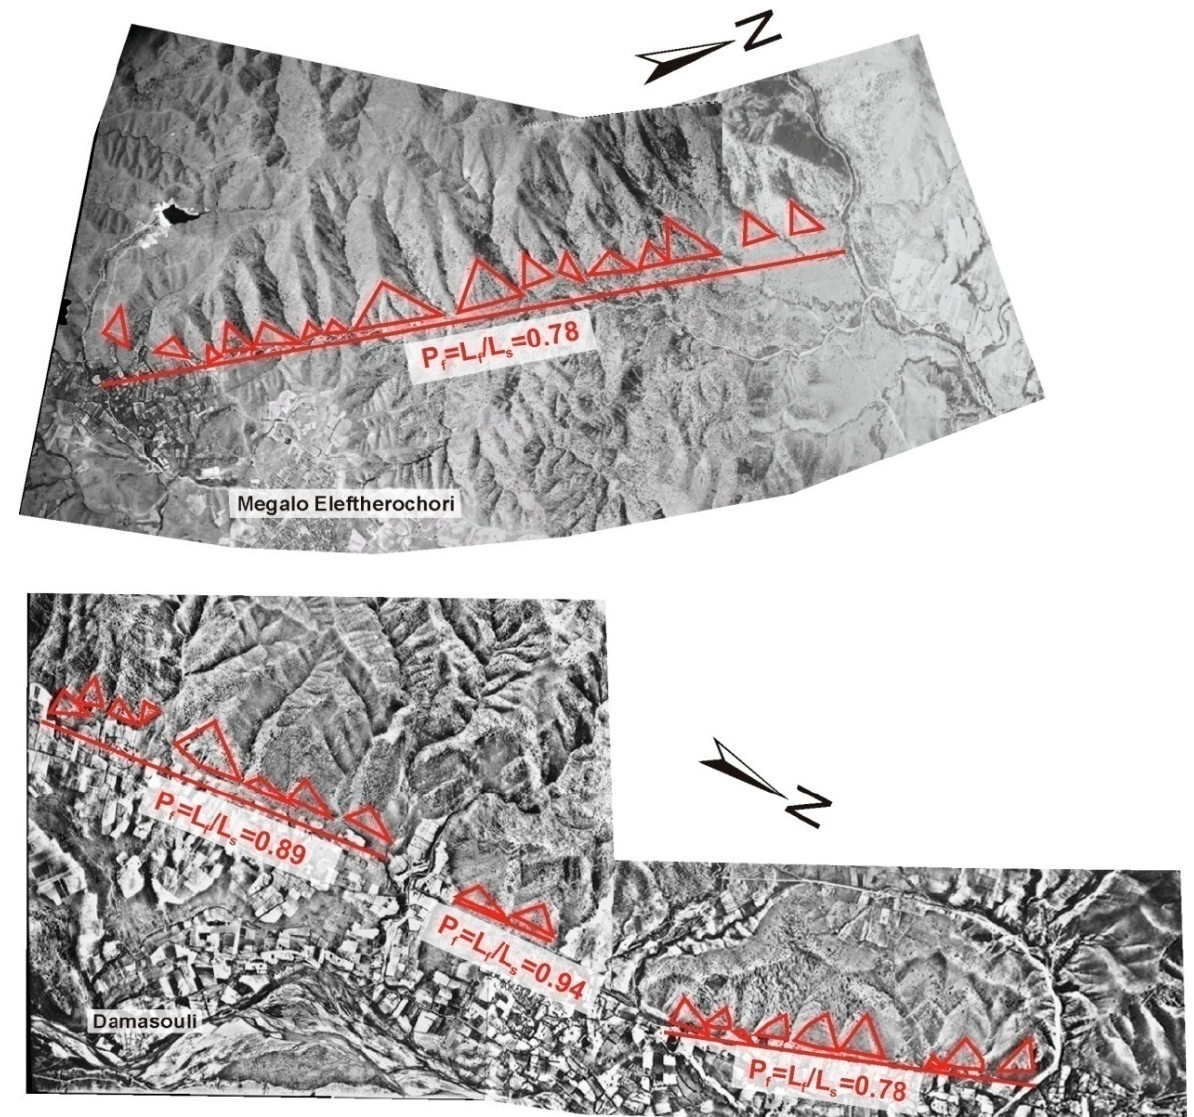
Figure 15. Triangular facets along mountain front of MEF ( top figure) and along the VF ( down figure). Triangular facets are plotted on 1974 ( top ) and 1960 ( down ) airphotos of